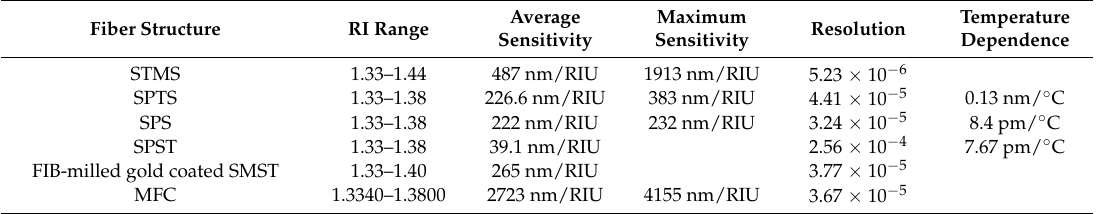
Table 1. Comparison of sensing parameters for different RI sensors proposed in our previous